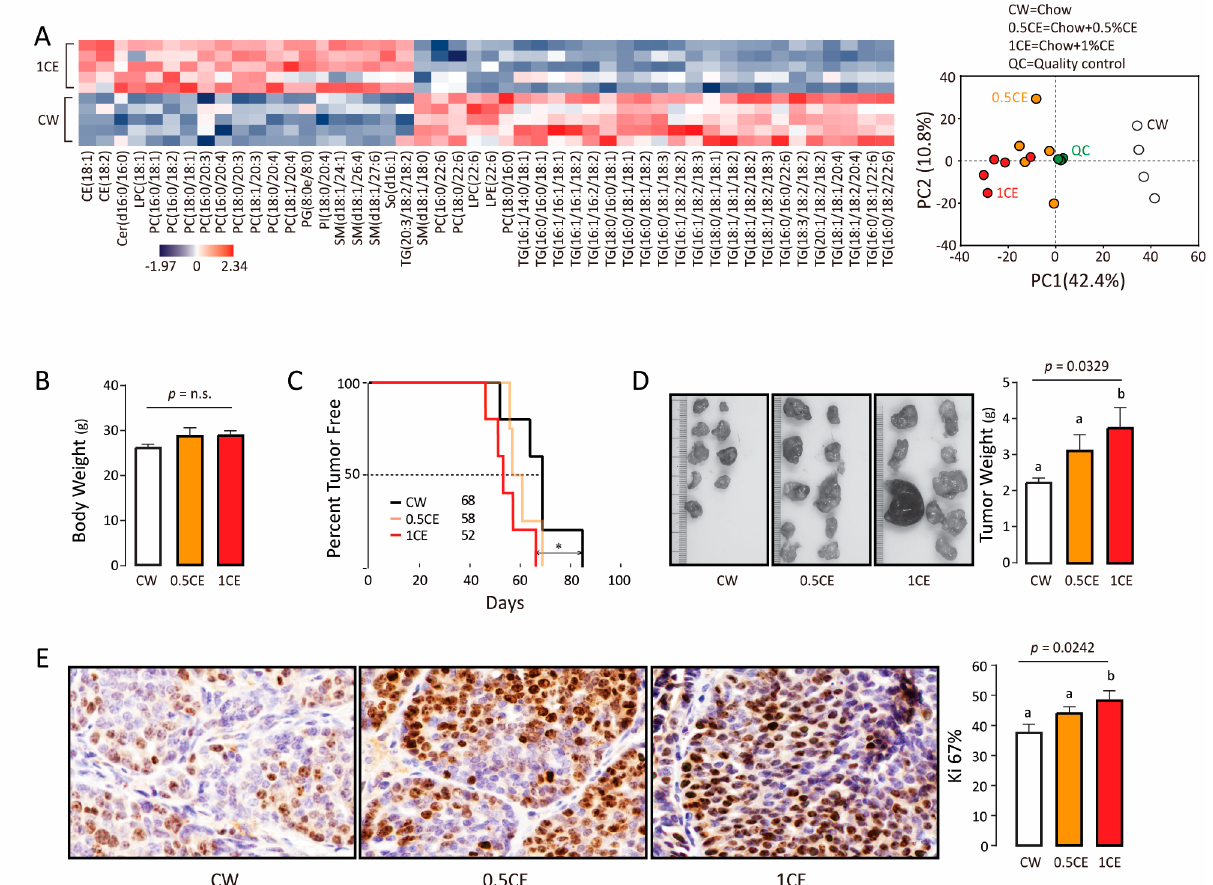
Figure 2. Dietary cholesteryl ester decreases tumor free survival. ( A ) Left: Heat maps of differentially expressed lipids in the serum of mice received diet with or without cholesteryl ester. CE, cholesterol ester; Cer, ceramides; LPC, lysophosphatidyl choline; PC, phosphatidyl choline; PG, phosphatidyl glycerol; PI, phosphatidyl inositol; SM, sphingomyelin; So, sphingosine; TG, triglyceride; LPE, lysophosphatidyl ethanolamine. 8:0, caprylic acid; 14:0, myristic acid; 16:0, palmitic acid; 16:1, palmitoleic acid; 18:0, stearic acid; 18:1, oleic acid; 18:2, linoleic acid; 18:3, α -Linolenic acid; 20:1, gondoic acid; 20:3, dihomo- γ -linolenic acid; 20:4, arachidonic acid; 22:6, docosahexaenoic acid; 24:1, nervonic acid; 26:4, hexacosatetraenoic acid; 27:6, heptacosahexaenoic acid. Right: Principal-component analysis (PCA) of the matrix data. PyMT mice received an increasing dose cholesteryl ester diet (with 5, 10 mg cholesteryl ester per kg added, n = 5). ( B ) Body weight of each group. ( C ) Tumor latency of each group. * p < 0.05. ( D ) Tumor weight of each group. Values (means ± S.E.M.) with different letters indicate statistical significance, p < 0.05. ( E ) Immunohistochemical staining of Ki-67 in mammary gland (tumor). Values (means ± S.E.M.) with different letters indicate statistical significance, p < 0.05.